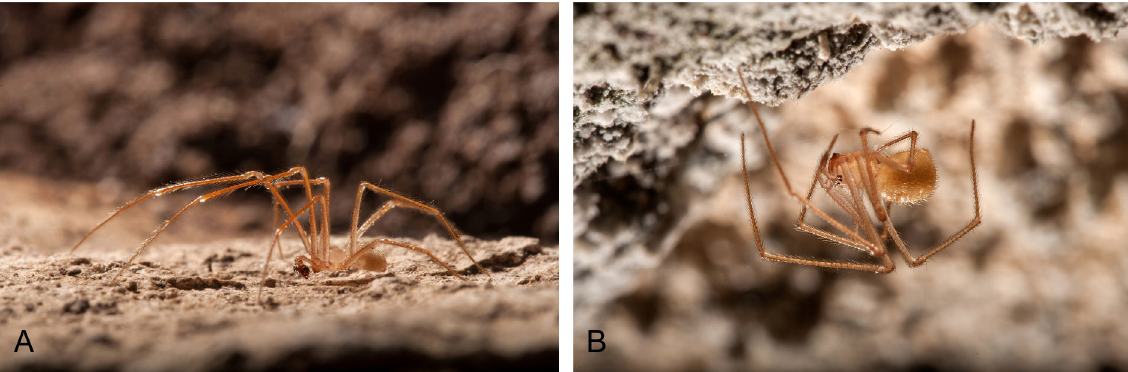
Fig 1. Habitus of Kryptonesticus deelemanae sp. nov. A . Male, body length 3.6 mm. B . Female, body length 4.3 mm. (Photos by M.